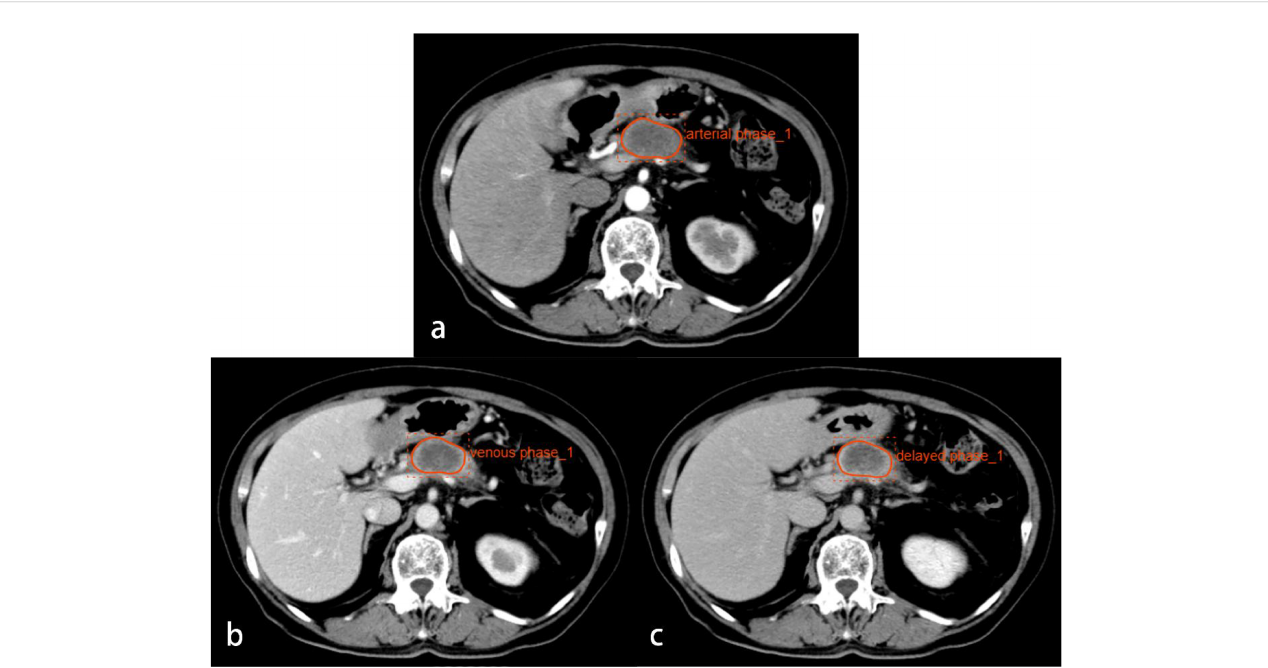
FIGURE 2 CT images from a 74-year-old woman with PDAC in the neck of the pancreas. Regions of interest are outlined in orange on arterial (A) , venous (B) , and delayed phase (C)